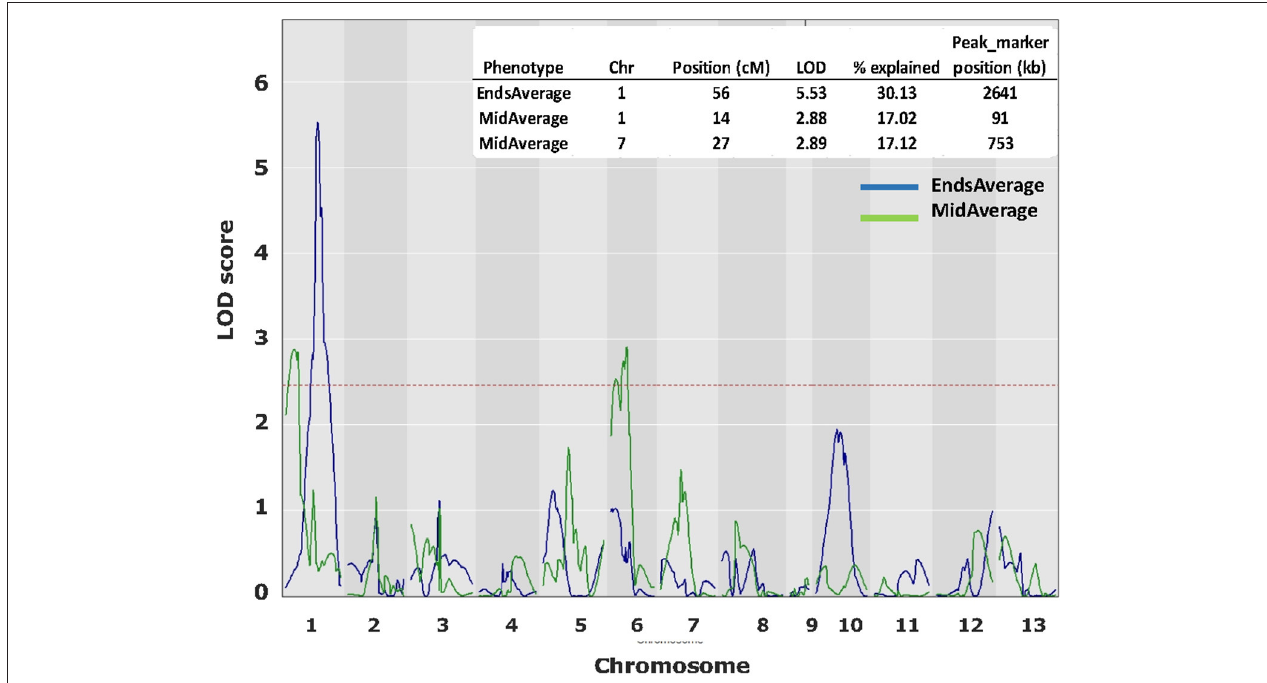
FIGURE 6 | QTL plots for CO landscape over 13 chromosomes. In blue the QTL plots for average CO at chromosome ends and in green the QTL plots for CO at the middle of chromosomes. QTL analysis was done with R (package QTL2) using Haley–Knott Regression to identify significant QTLs. LOD threshold ( < 0.1): 2.49.